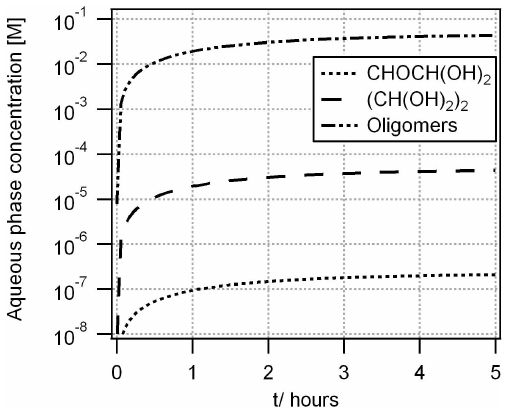
Fig. 2. Predicted concentration profiles glyoxal monohydrate CHOC(OH) 2 , dihydrate (CH(OH) 2 ) 2 and oligomers as a function time. The time scale to reach equilibrium is due to the kinetics of the hydration processes ( k hydr1 , k 0 oligomerization ( K olig = k olig / k 0